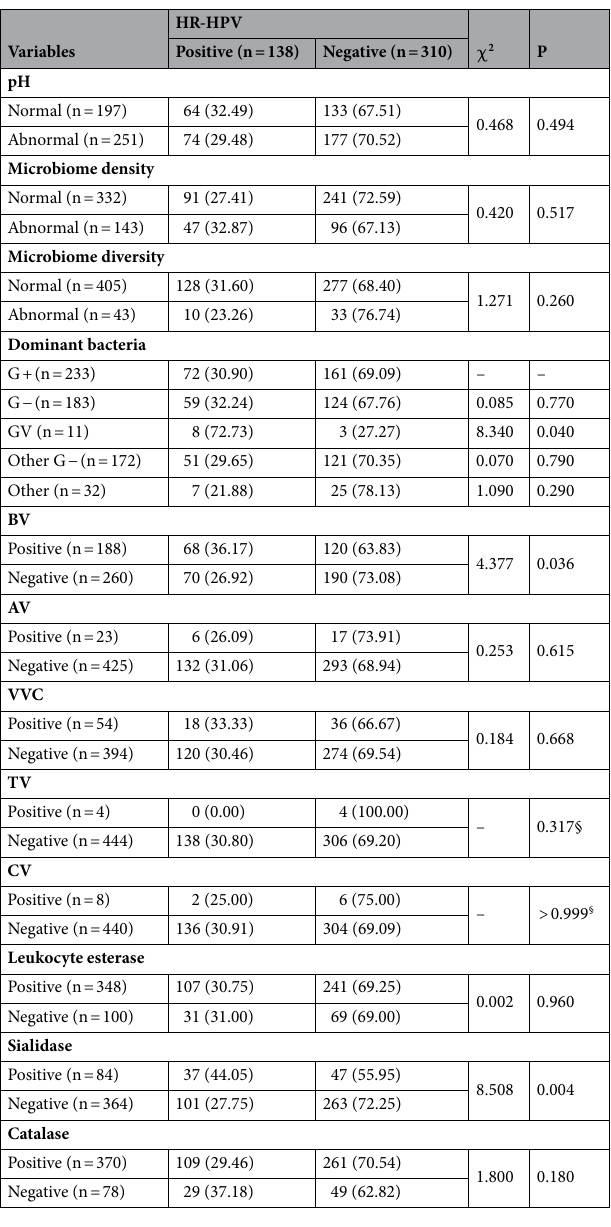
Table 3. The changes of micro-environment factors between different HR-HPV infection women. Normal pH values between 3.8–4.5, and the rest are regarded as abnormal pH values. The normal flora diversity is the flora diversity ++ to +++, the normal flora density is the flora density ++ to +++, the rest is regarded as the flora diversity and the flora density abnormality. G + Gram-positive bacteria, G− Gram-negative bacteria, GV Gardnerella vaginalis, AV aerobic vaginitis, BV bacterial vaginosis, CV cytolytic vaginosis, TV trichomonas vaginitis, VVC vulvovaginal candidiasis. § Is Fisher’s exact test